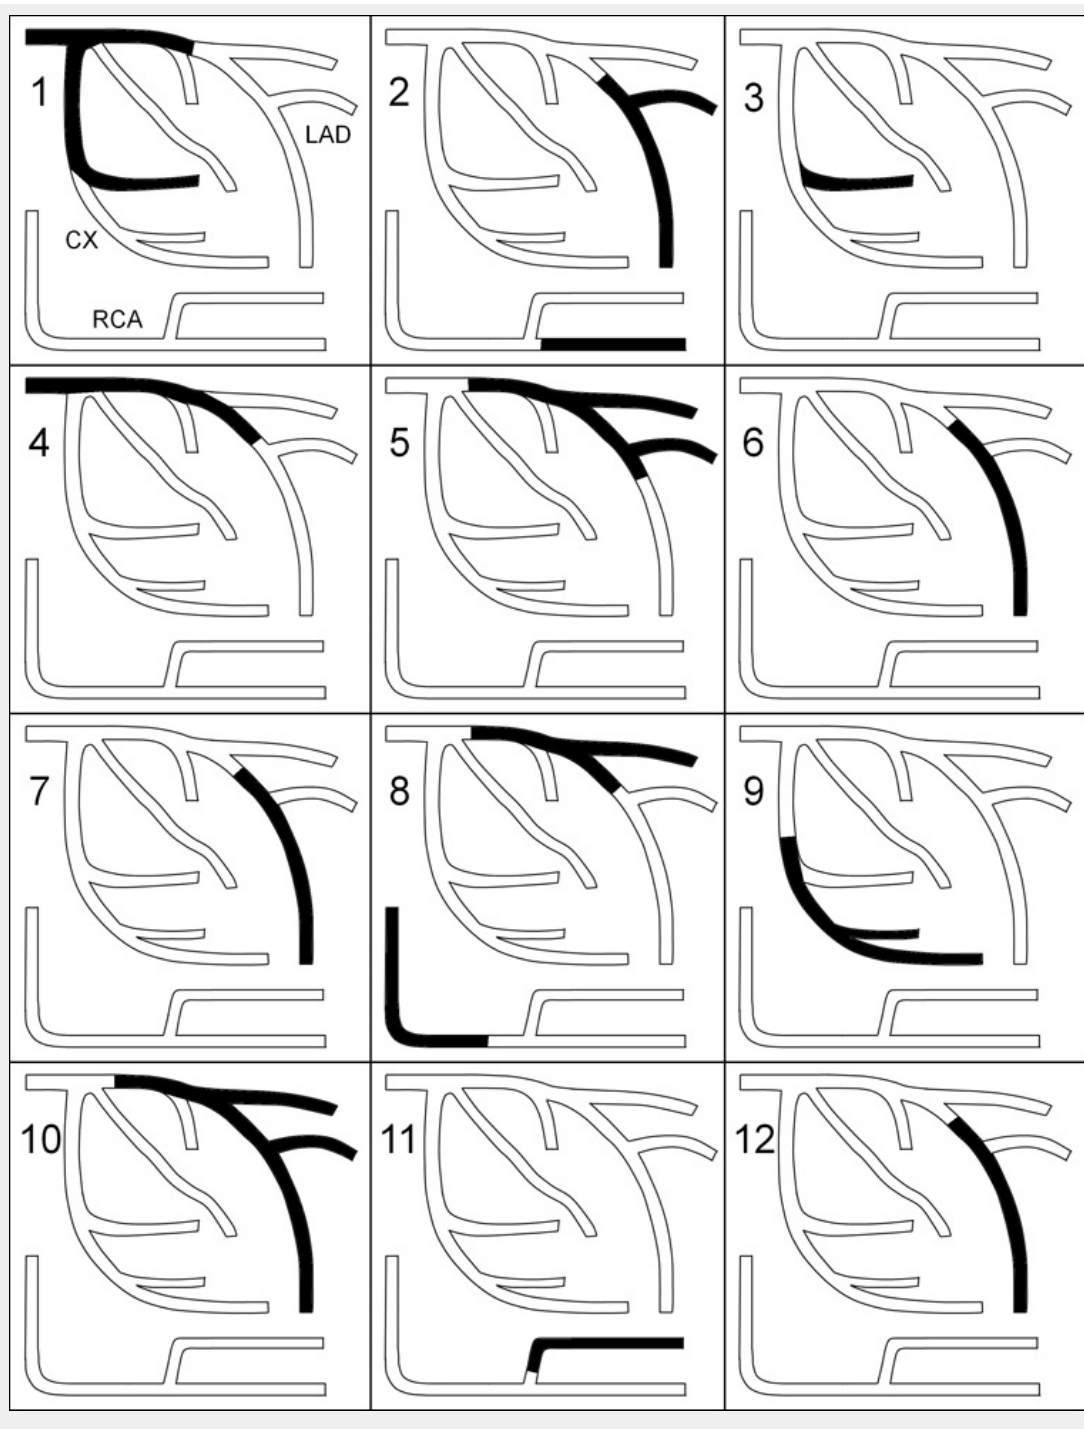
Figure 2 Segmental distribution of coronary artery dissections in patients with (1–3) and without (4–12) renal artery